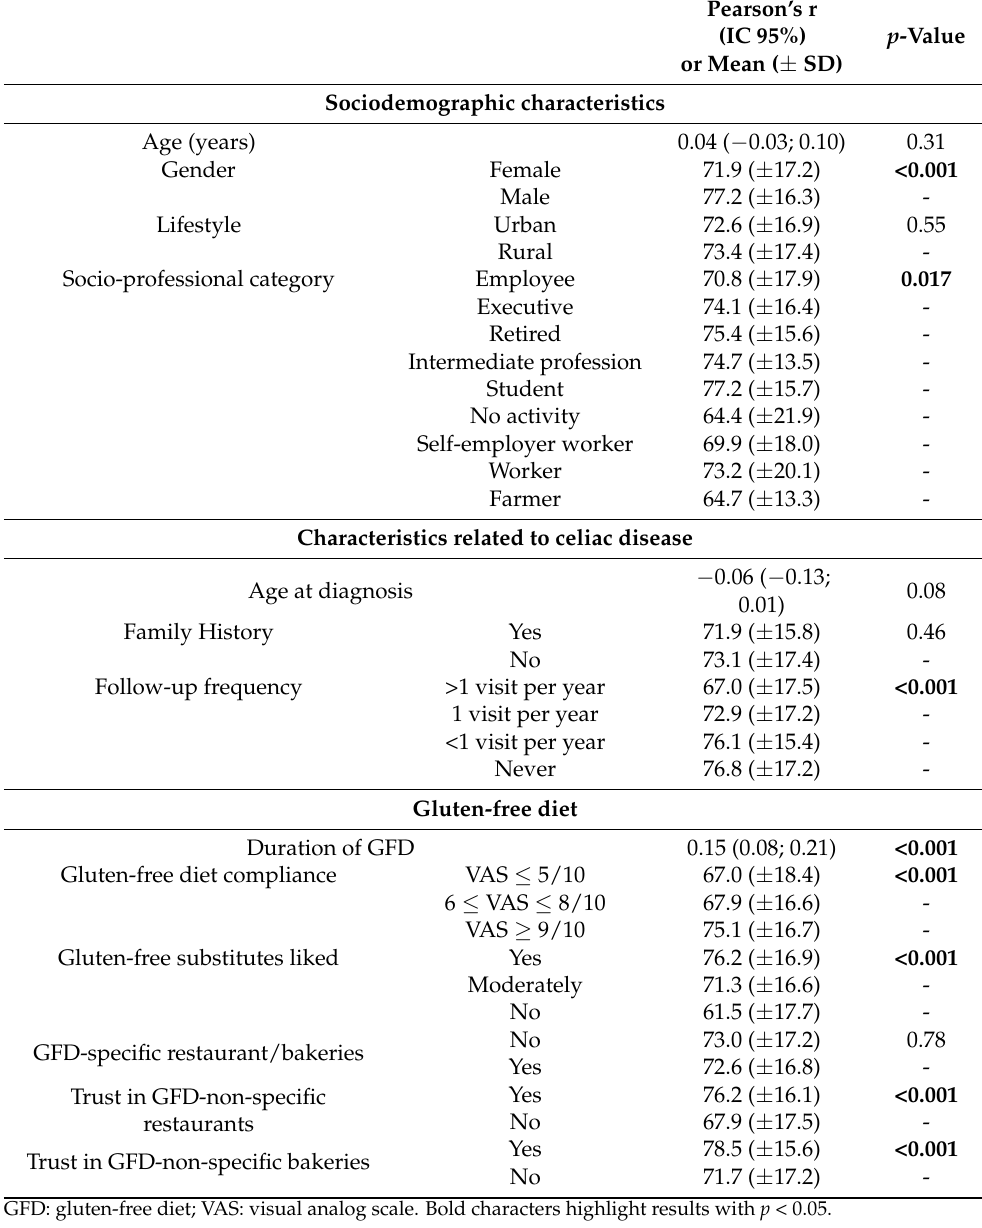
Table 3. Total F-CDQ score according to patients and disease characteristics.